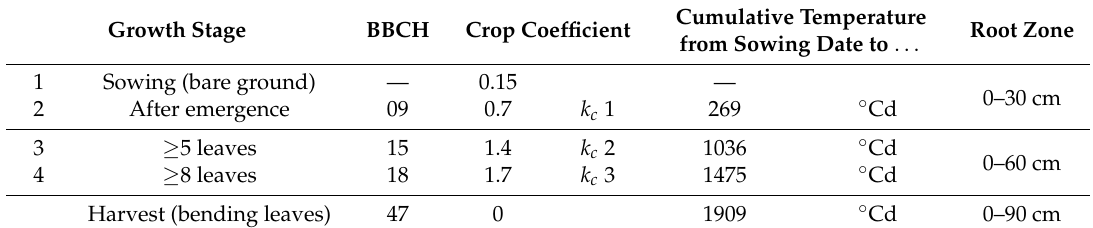
Table 2. Crop coefficients ( k c -values) evaluated at the Geisenheim University) for Geisenheimer irrigation scheduling according to required accumulated temperature ( ◦ Cd) for onion phenological growth stages based on BBCH code.(See http://www.hs-geisenheim.de/fileadmin/user_upload/